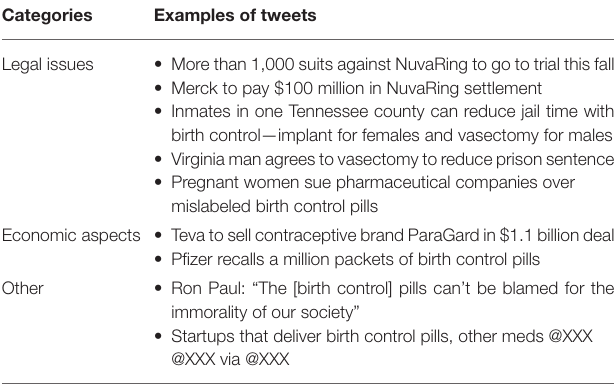
TABLE 2 | Definitions of the non-medical categories and